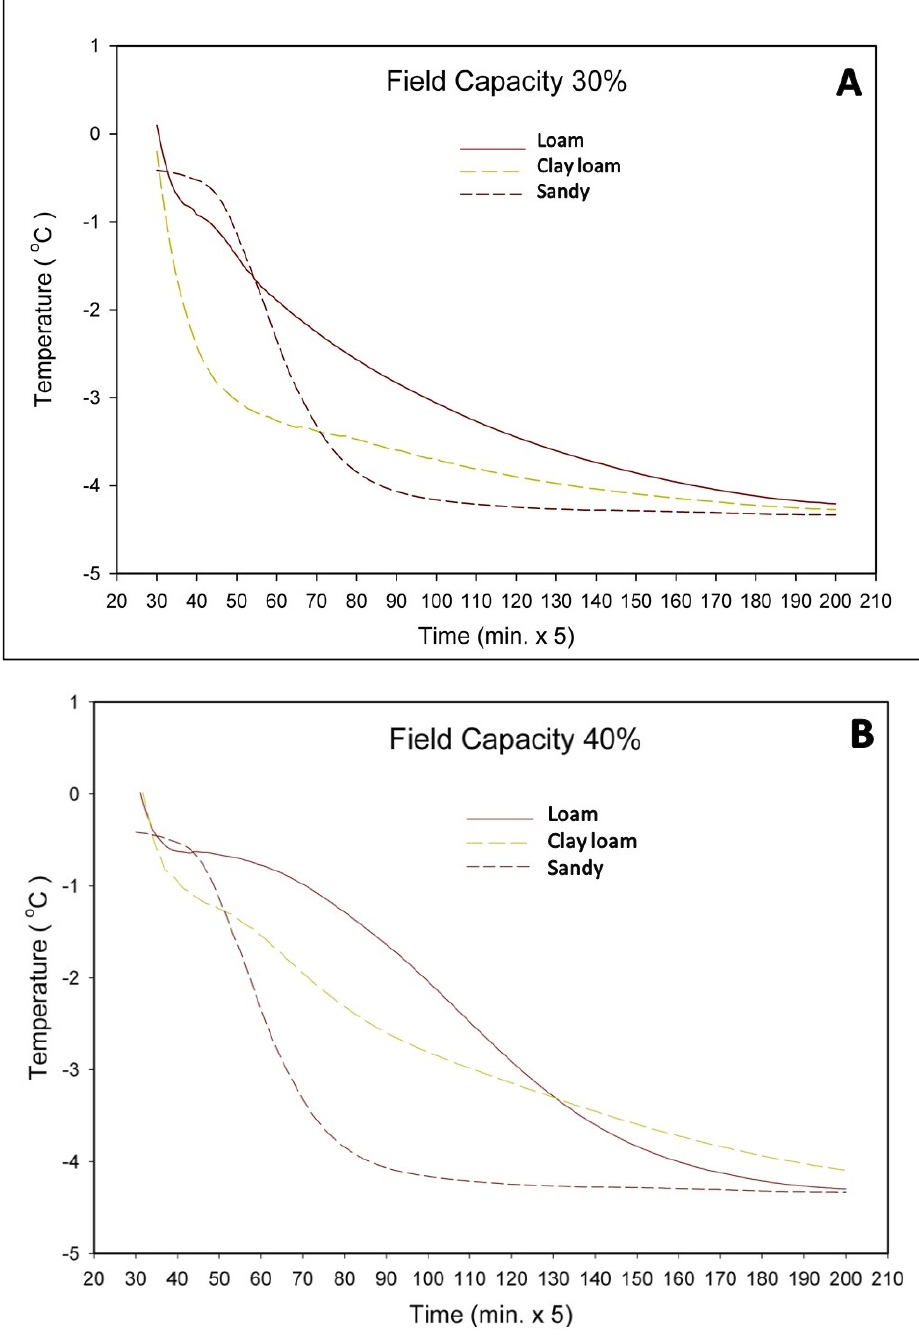
Figure 2. Freezing profiles of three soil types at two moisture contents: ( A ) 30% field capacity. ( B ) 40% field capacity. Each curve is based on two runs and four replications within each run.